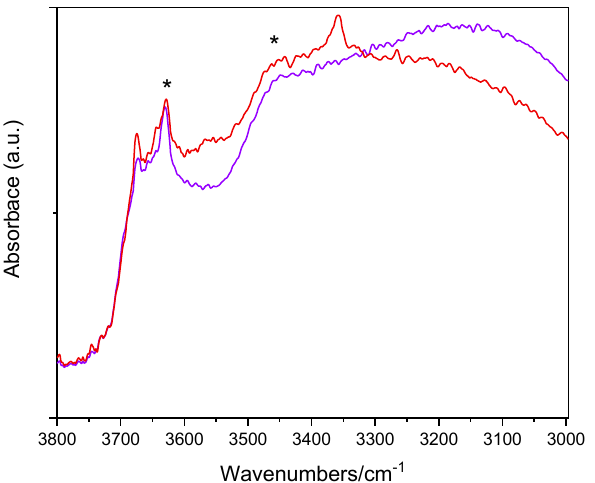
Figure 5. Selected IR spectra obtained with the undoped TiO 2 sample (purple) and the Fe(2.5)-TiO 2 sample (red). The bands at 3630 and~3460 cm − 1 are labelled by asterisks (*).